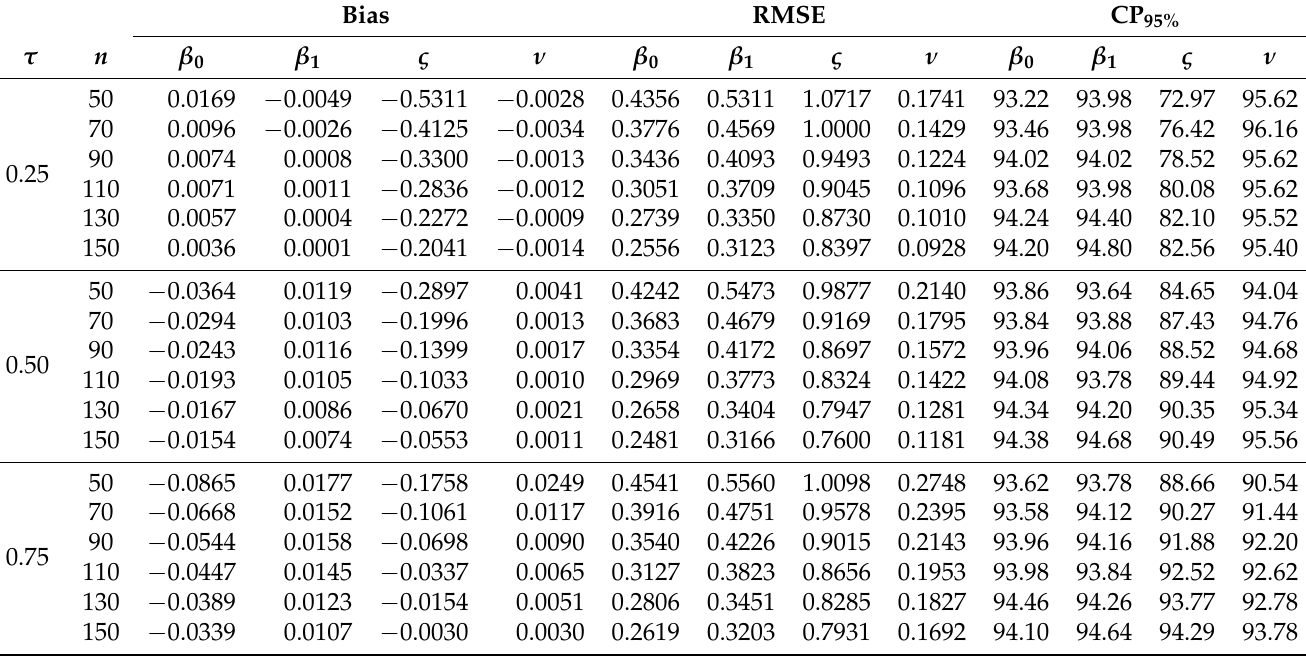
Table 9. Empirical RMSE, bias, and 95% CP (true values: β 0 = 0.50, β 1 = 0.50, ς = 2.00, and ν = 1.00) of the ML estimator for the indicated parameter with simulated data.